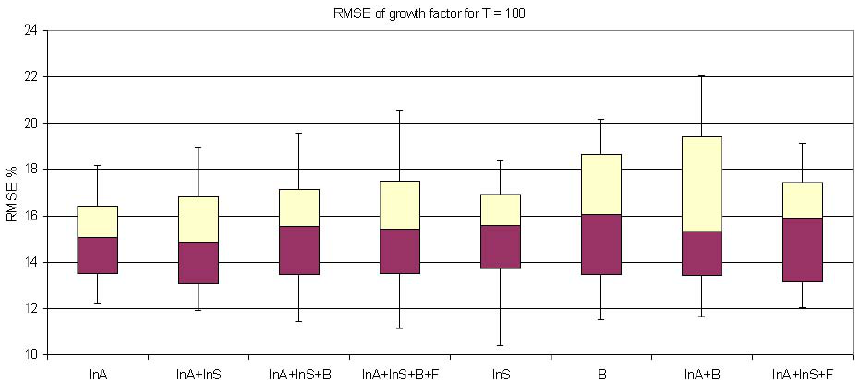
Fig. 1. Box-plot of RMSE of growth factors corresponding to 100yr return periods for different sets of catchment descriptors used in defining the distance measure d ij . Each Box-plot gives the percentiles for the frequencies 0.05, 0.25, 0.5, 0.75, 0.95.